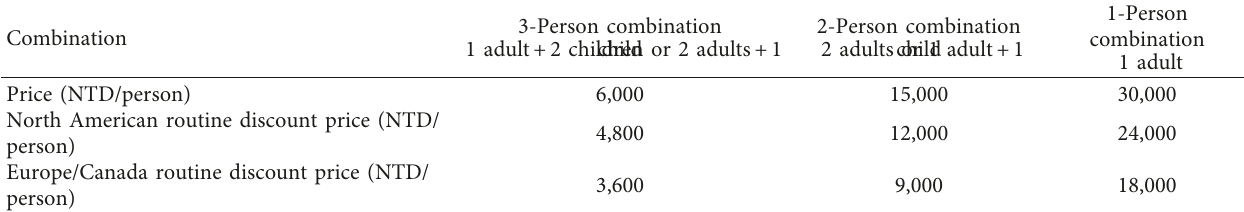
Table 1: Family couch combination and pricing provided by China